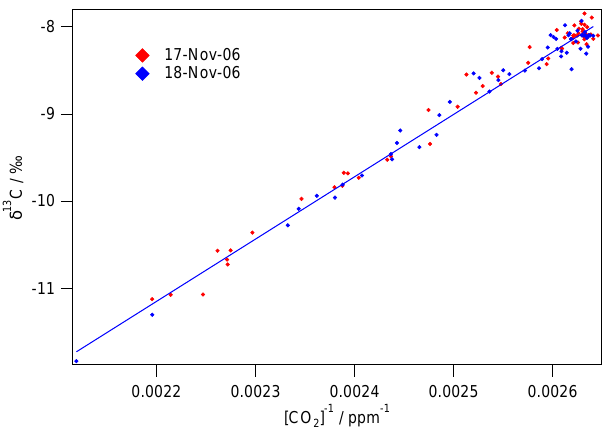
Fig. 12. Keeling plot of δ 13 C vs. 1/[CO 2 ] for two nights drawn from the data shown in Fig. 11. The mean intercept is − 26.8 ± 0.4‰, indicative of respiration from the dominant C3 plants in the